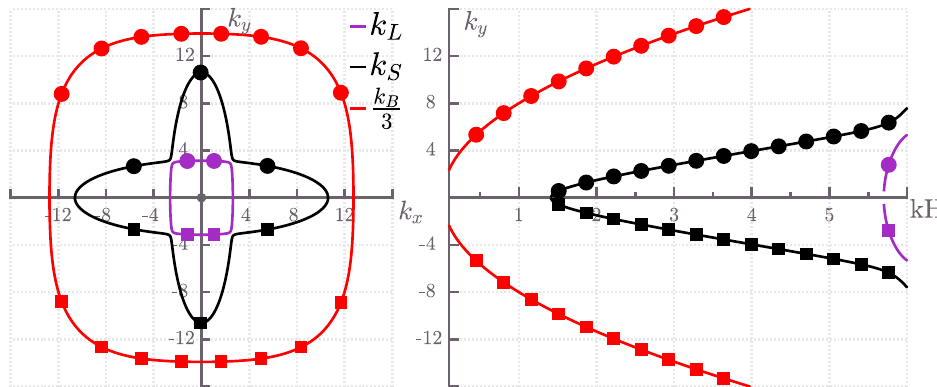
Figure 6. Wave vector (left) and dispersion (right) curves for a cross-ply composite plate. Longitudinal ( k L ), shear ( k S ) and bending ( k B ) curves are depicted in purple, black and red colour, respectively. Squares and circles denote wave numbers of incoming and outgoing waves, respectively. The wave vector curves are plotted for a fixed frequency f 0 = 3000 Hz, whereas the dispersion curves are plotted for a fixed wave number component = 5m − 1 k 0 x